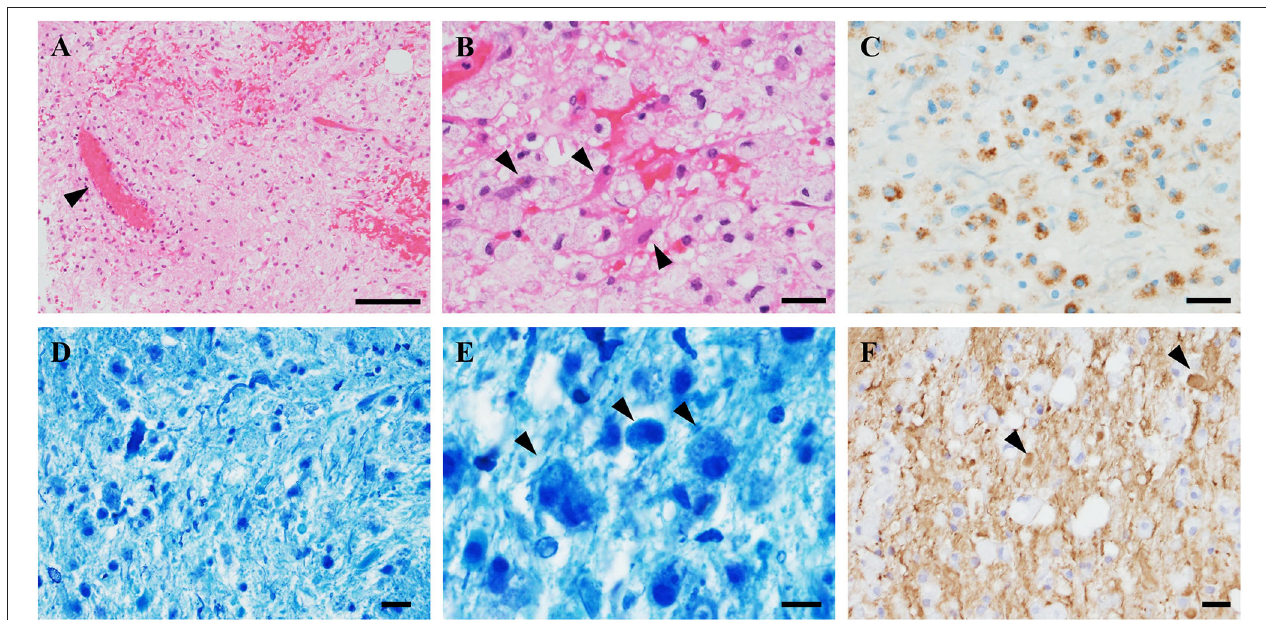
FIGURE 2 | Pathological findings of the brain biopsy. (A) Hematoxylin and eosin (HE) stains showed gliosis with widespread infiltration of inflammatory cells without neoplastic tissue. Perivascular inflammation was absent (arrowhead). (B) High-magnification HE showed diffuse foamy macrophage infiltration associated with reactive astrocytes (arrowheads). (C) CD68-immunostaining revealed clusters of macrophages. (D,E) Klüver–Barrera staining demonstrated myelin loss with myelin-laden macrophages (arrowheads). (F) Phosphorylated neurofilament immunostaining revealed axonal fragmentation and spheroids (arrowheads). The axonal loss was milder than myelin loss. Scale bars: (A) 100 µ m. (B–E) 20 µ m. (F) 10 µ m.